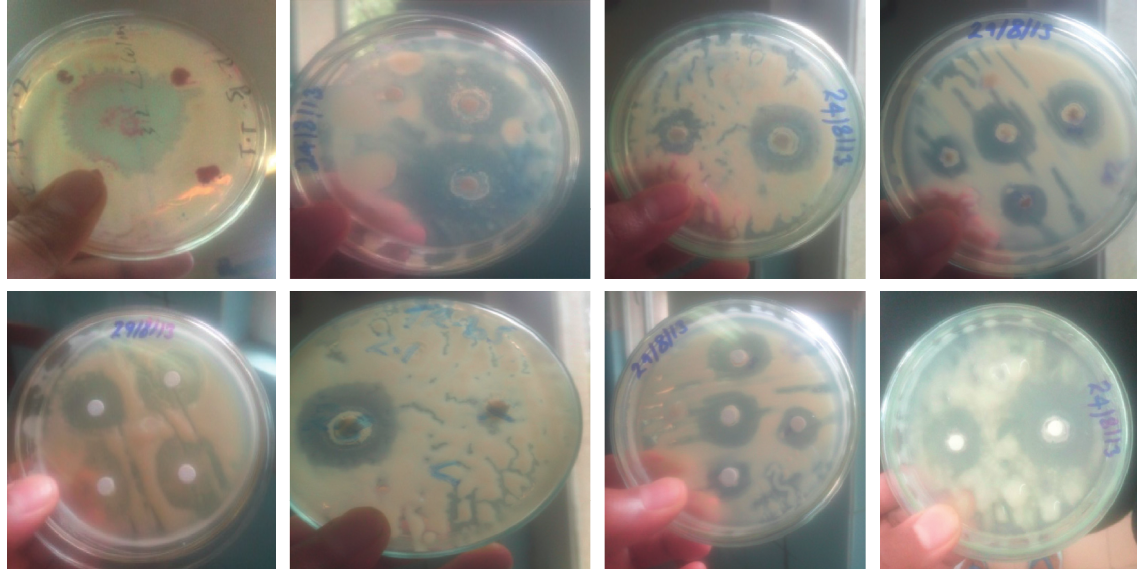
Figure 2: Antagonistic activities (inhibition zones) of the different rhizosphere bacteria against the pathogen ( R. solanacearum